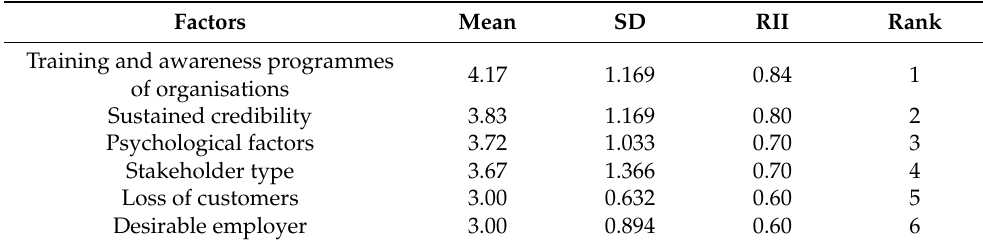
Table 8. Classification under